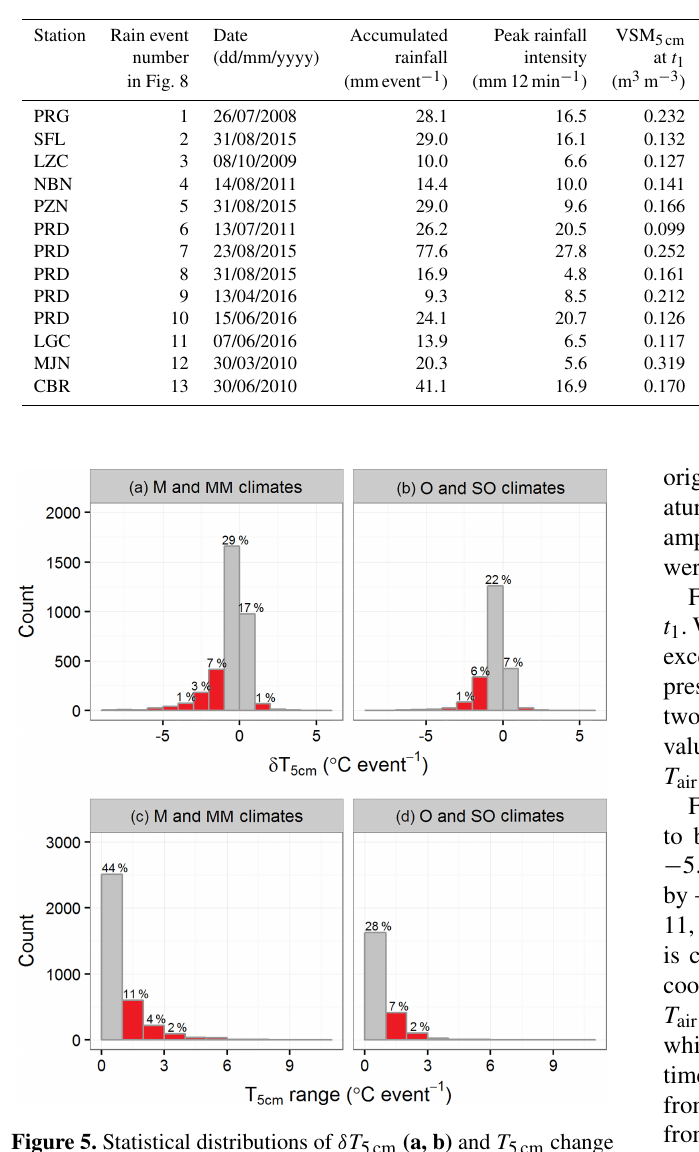
Figure 5. Statistical distributions of δT 5cm (a, b) and T 5cm change range (c, d) during 5714 marked rainfall events for Mediterranean (M) and Mediterranean–mountain (MM) stations (a, c) and for oceanic (O) and semi-oceanic (SO) stations (b, d) . The percent value is the ratio of the count of each bin to the total count in all climate conditions. Bin width is 1 ◦ C. Bins for values larger than 1 ◦ C or smaller than − 1 ◦ C are in